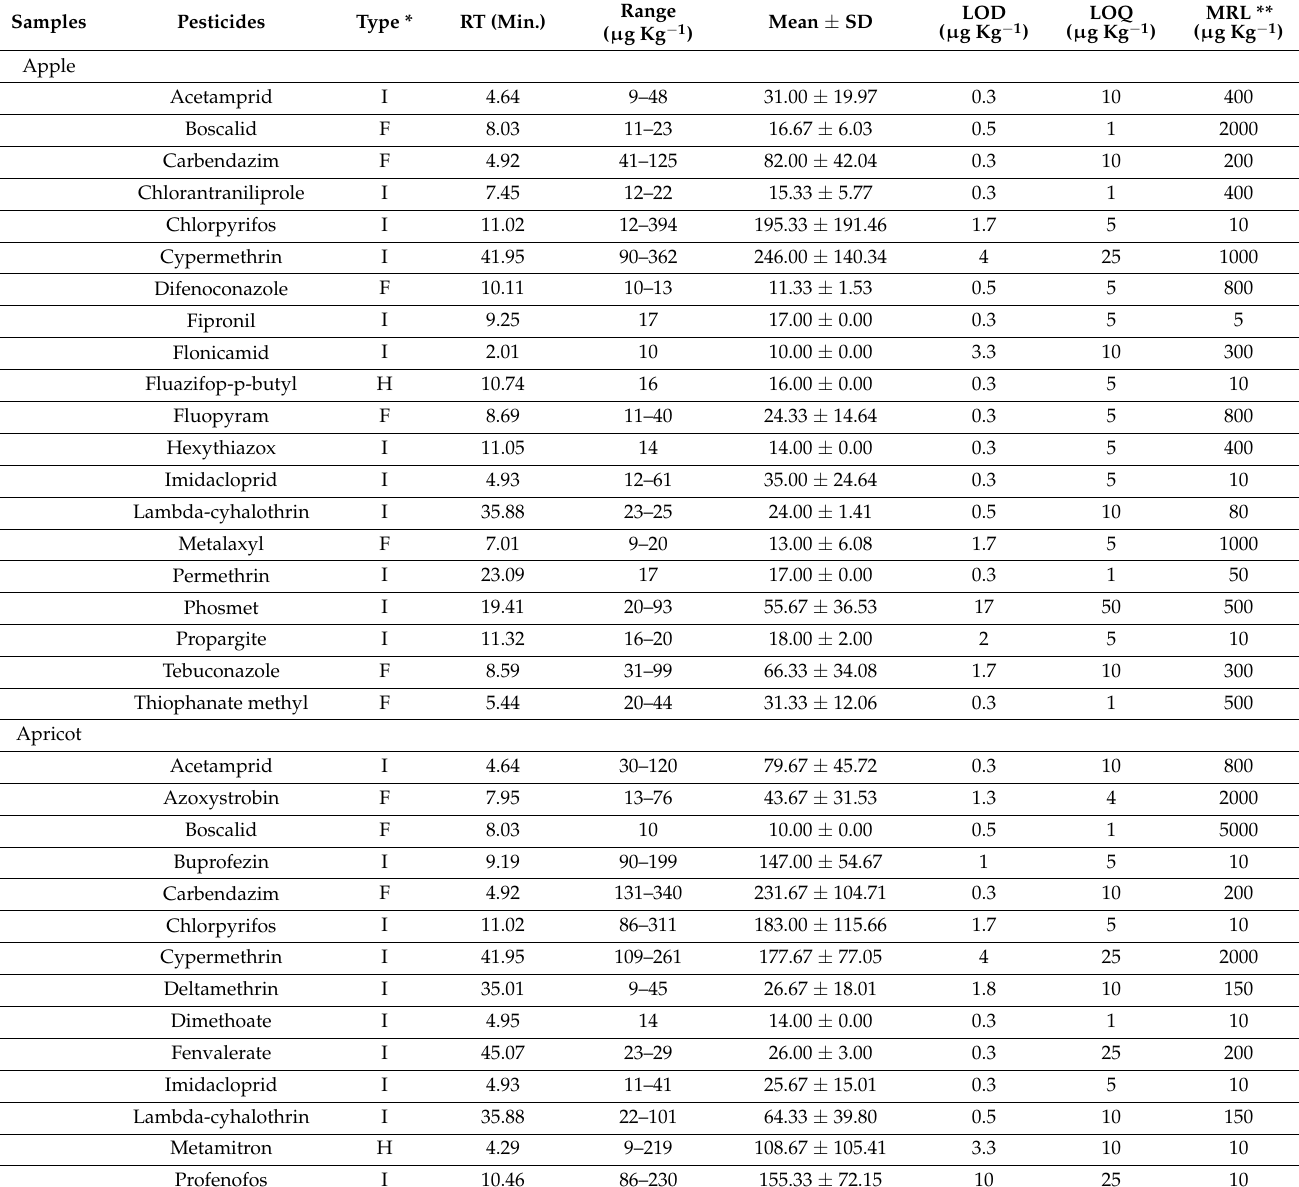
Table 2. Range and mean concentrations of pesticide residues ( µ g Kg − 1 ) found in fruit samples collected from farmer markets in Sharkia Governorate,